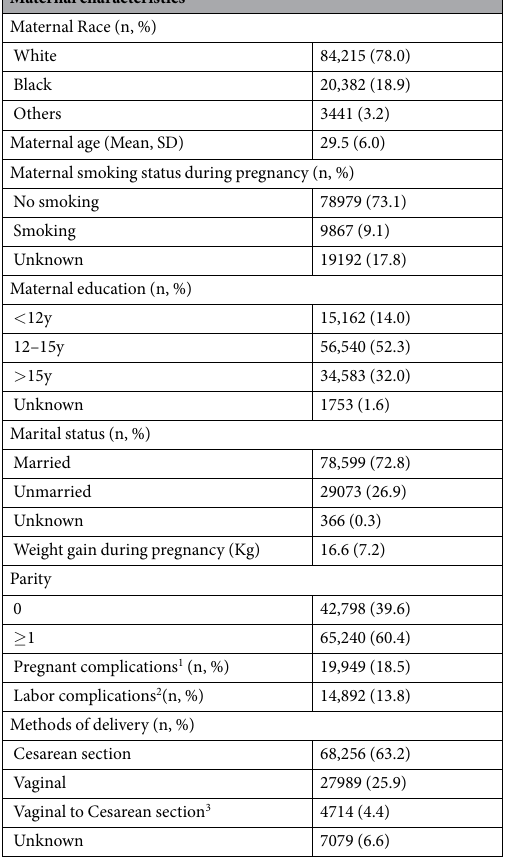
regression analysis was performed to calculate the crude odds ratios (ORs) and 95% confidence intervals (CIs) of the differences in outcomes between the male and female members of mix-gender twins. A multiple conditional logistic model was constructed to adjust for unmatched confounders. A p-value < 0.05 was considered statisti- cally significant. All analyses were carried out using SAS version 9.2 (SAS Institute Inc, Cary, NC).